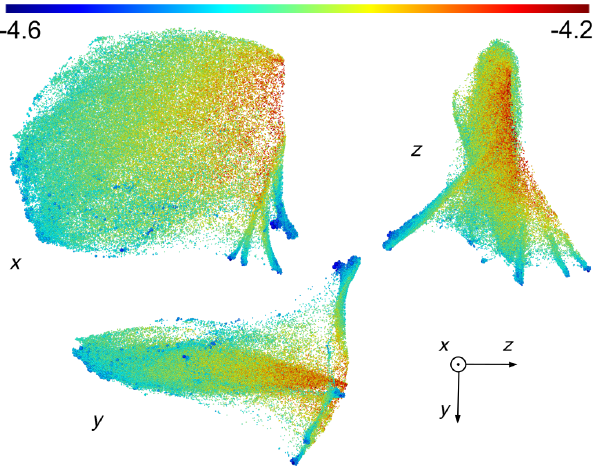
FIG. 7. Three perpendicular perspectives of a 3D SHEAP map produced from the same set of LJ 38 minima that are presented in Fig. 6. The projection uses a perplexity of 30, with a minimum sphere radius R 0 ¼ 0 . 008 . The spheres representing each struc- ture are colored according to energy per atom in Lennard-Jones units; see the color bar at the top of the figure. Basin volumes are represented by the volume of each sphere. Each viewpoint looks down one of the axes displayed at the bottom right of the figure; the axes have no other physical